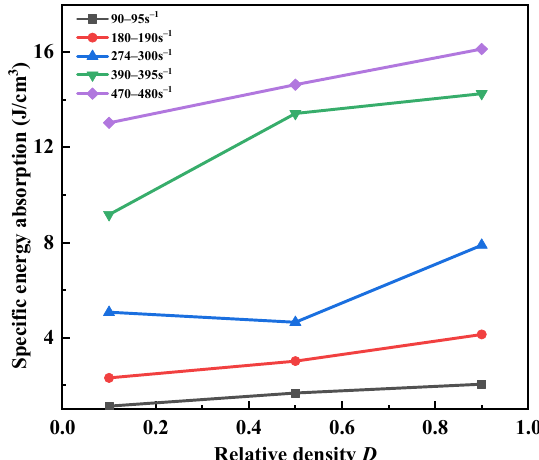
Figure 21. Variations in specific energy absorption with relative density at different strain rates.